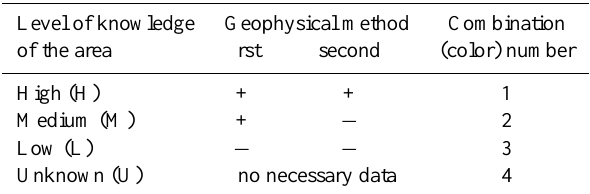
Table 1. Subdivision of an archaeological according to results of geophysical